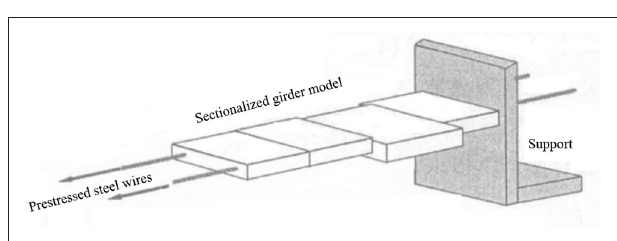
FIGURE 2 | Configuration of a taut strip